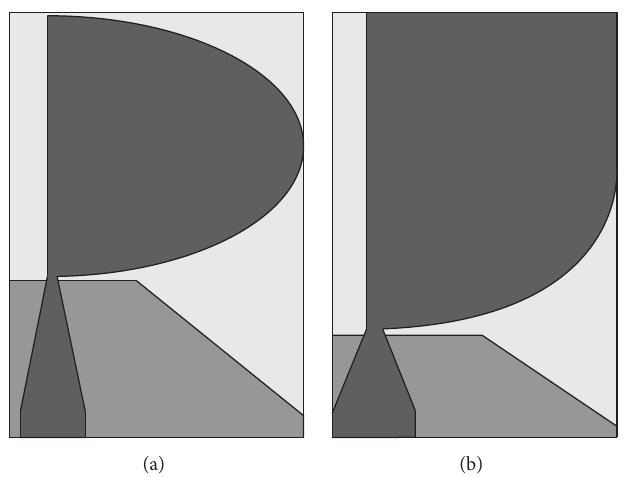
Figure 14: Configuration of the half-size (a) and of the compact UWB antenna (b) [52]. Dark gray upper metal face, medium gray bottom metal face, and light gray dielectric substrate.